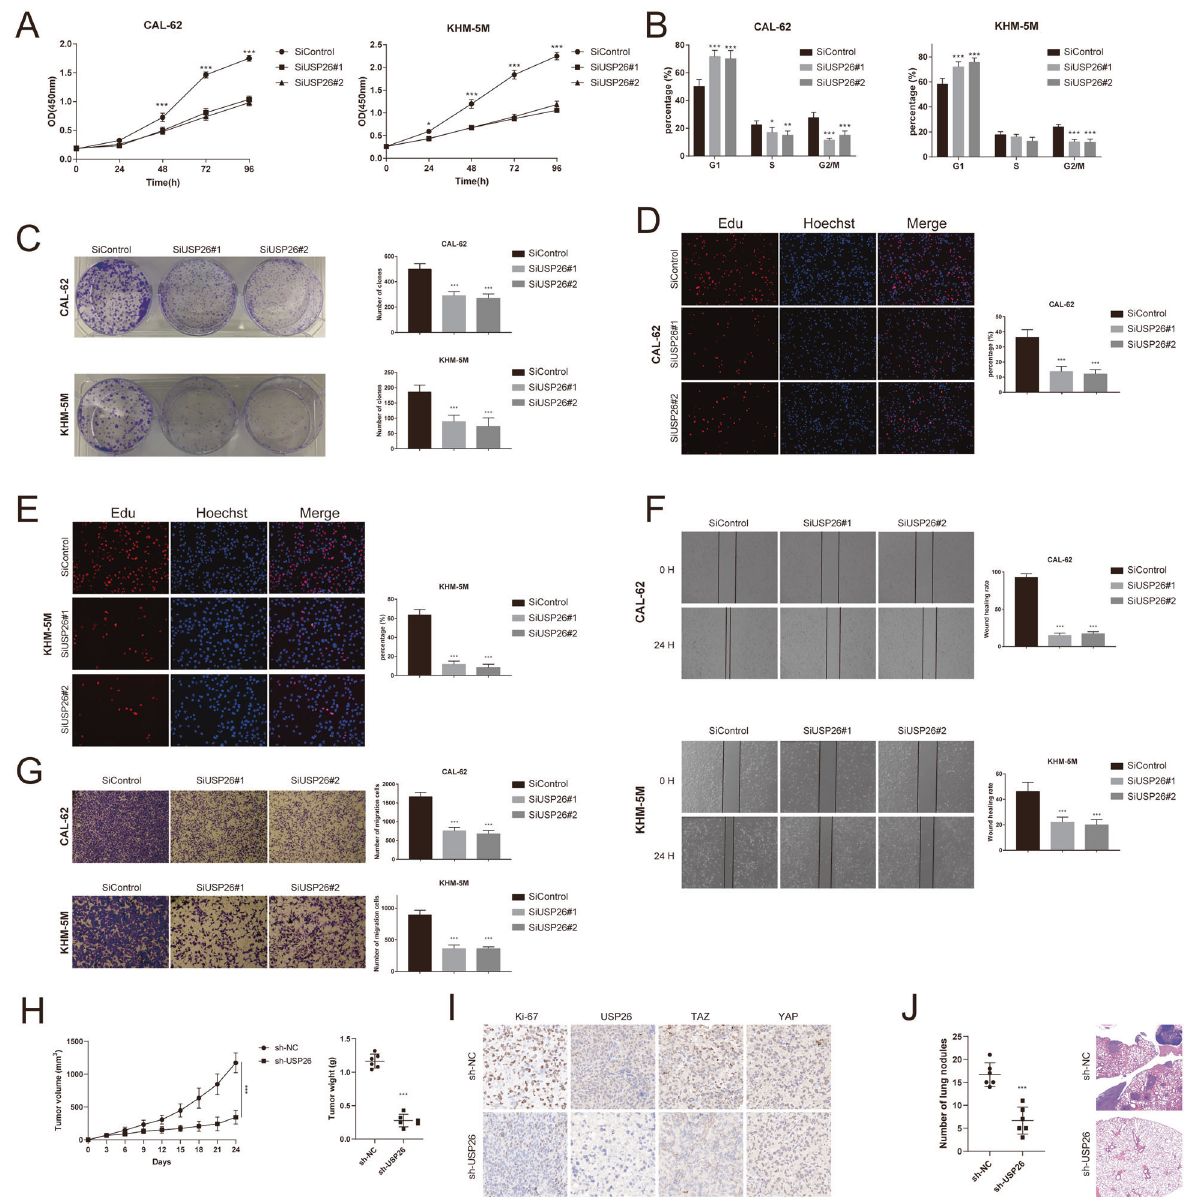
1 × 10 6 CAL62 cells were injected to the right dorsal fl ank of each mouse ( n = 6). Tumor sizes were measured every 3 days until the end of the experiment. I Representative images of immunohistochemical staining for Ki67, USP26, and TAZ. J USP26 depletion suppressed the lung metastasis of ATC in mice. 0.5 × 10 6 ATC cells were intravenously injected into each mouse through the tail vein. The lungs were harvested 4 weeks after injection. * P value < 0.05; ** P value < 0.01; *** P value <